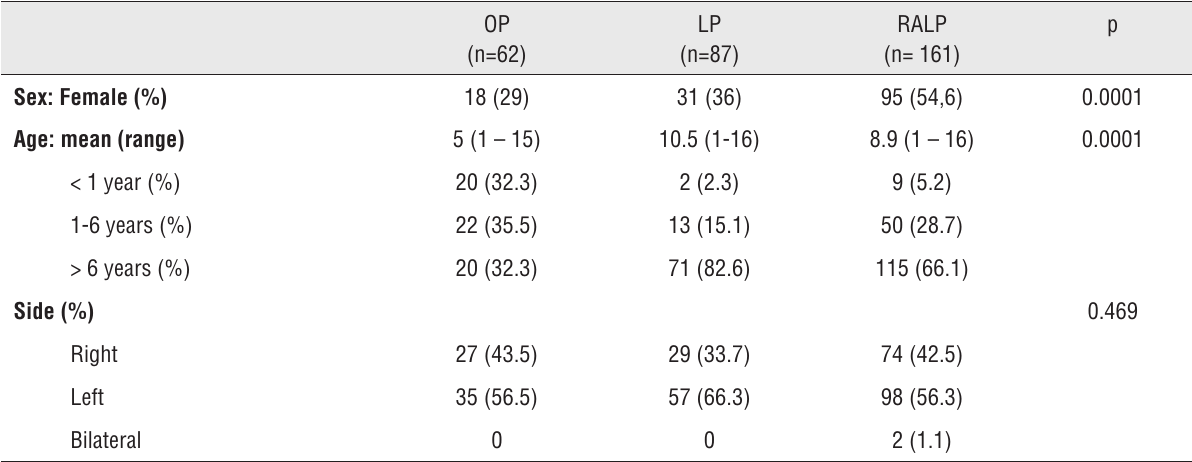
Table 1 - Sex, Age and Side of UPJO of patients submitted to open, laparoscopic and robotic